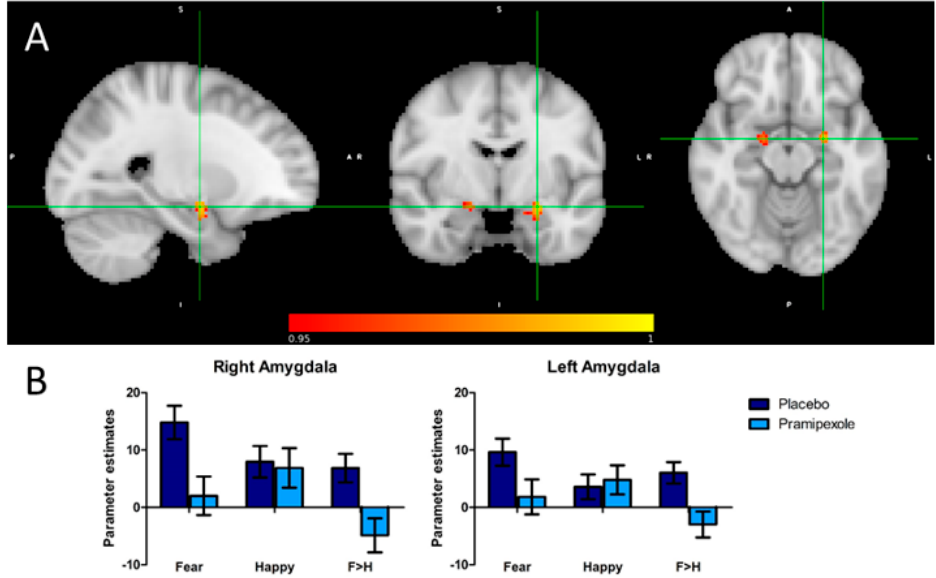
Figure 1. ( A ) Sagittal, coronal and axial images depicting significantly reduced activation in the pramipexole relative to the placebo group for the fear versus happiness contrast in the left and right amygdala. Peak voxels right amygdala: x = 18, y = − 6, z = − 14; voxel size: 35; 1 − p = 0.979. Peak voxels left amygdala: x = − 24, y = − 6, z = -14; voxel size = 83; 1— p = 0.994. Results are shown TFCE-corrected with a family-wise error cluster significance level of 1— p > 0.95. ( B ) Parameter estimates extracted from the significant clusters in response to fearful versus happy faces. Error bars represent the standard error of the mean.